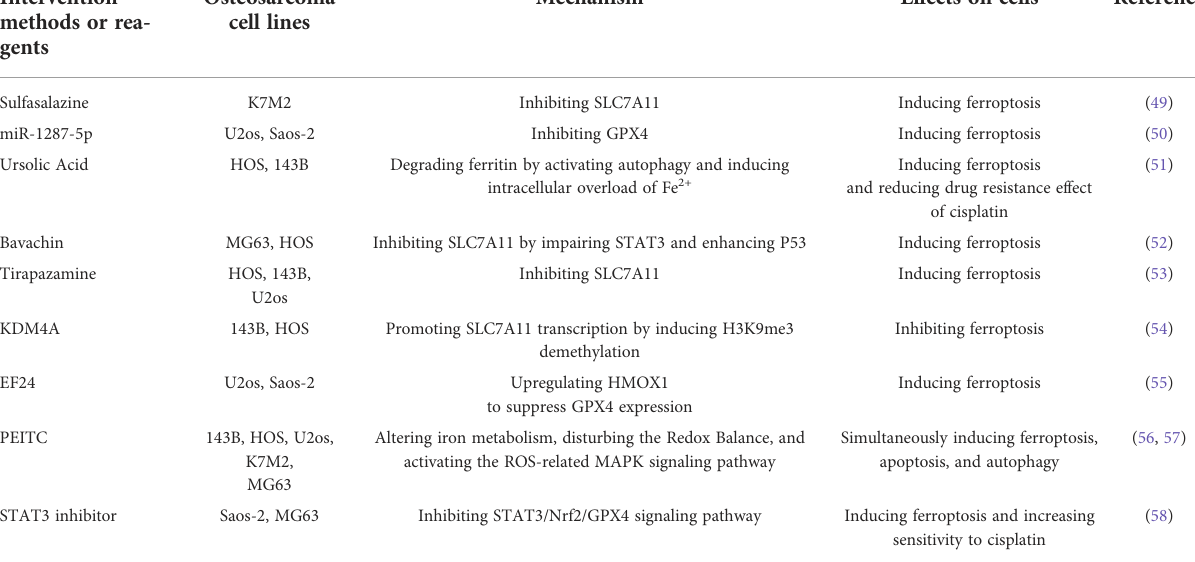
TABLE 1 Interventions and reagents targeting ferroptosis for osteosarcoma. Intervention methods or